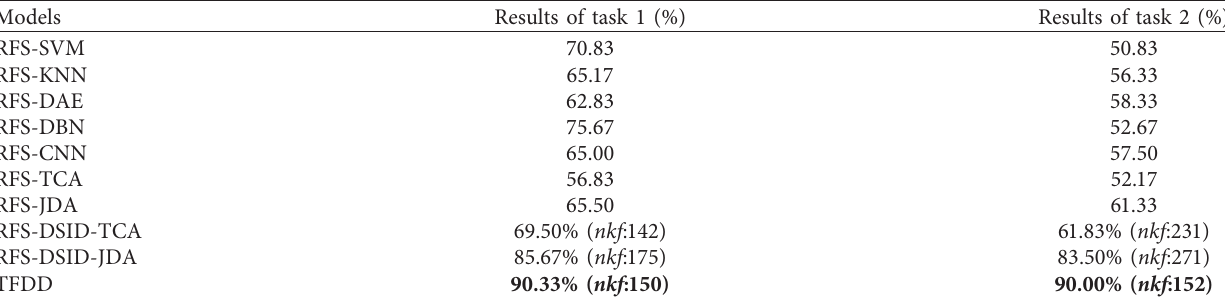
Table 10: Cross-domain fault diagnosis results of comparative